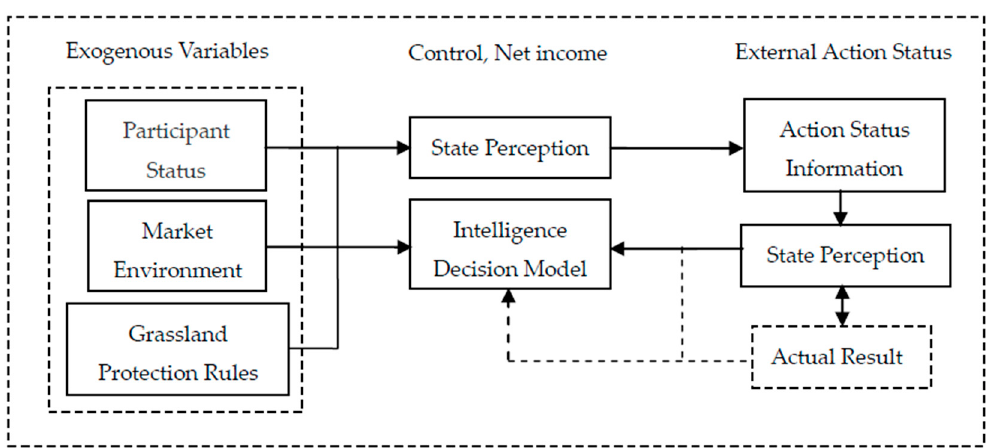
Figure 2. The participants’ intellectual decision model.